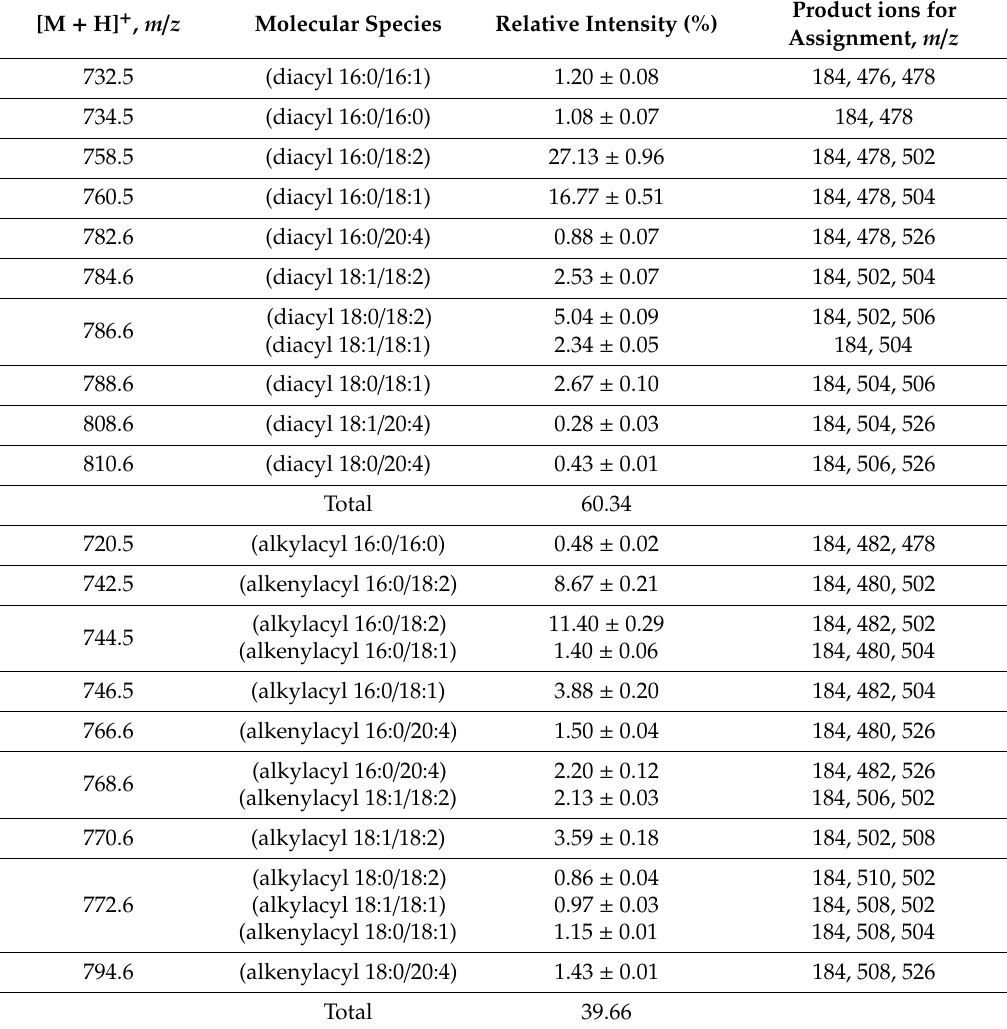
Table 1. Phosphatidylcholine (PC) species in pork chop detected by LC–electrospray ionization (ESI)–MS /